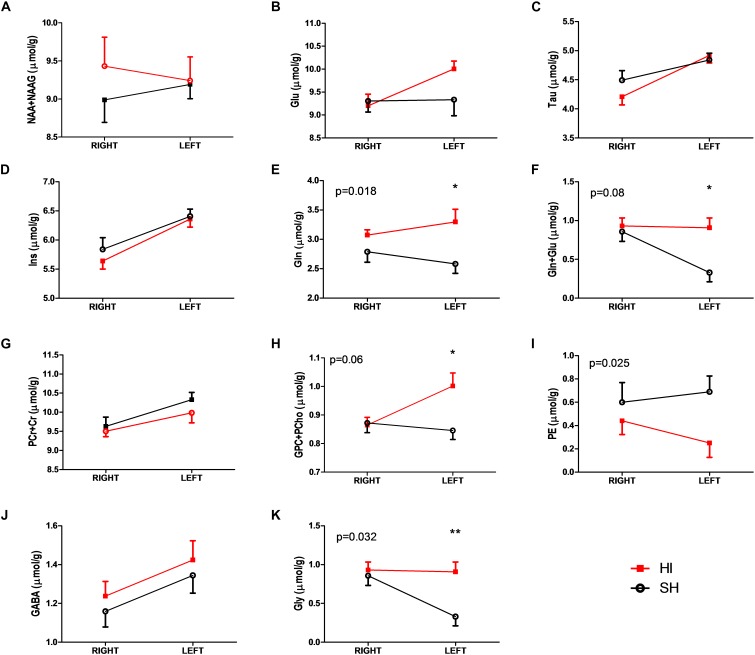
Selected metabolic differences (A–K) between SH (open black circles) and HI (solid red squares) groups of adult rats following HI and SH at PND3. Two-way ANOVA analysis showed treatment differences with the corresponding p-values (E,J,K). Total choline (GPC+PCho, H) and total glutamine and glutamate (Gln+Glu, F) showed different trends toward the significant level, i.e., p < 0.05. The further Bonferroni post-test revealed further differences, p-value <0.05 was marked with “∗” and p-value <0.01 was marked with “∗∗.” Abbreviations were listed in the “Materials and Methods.”